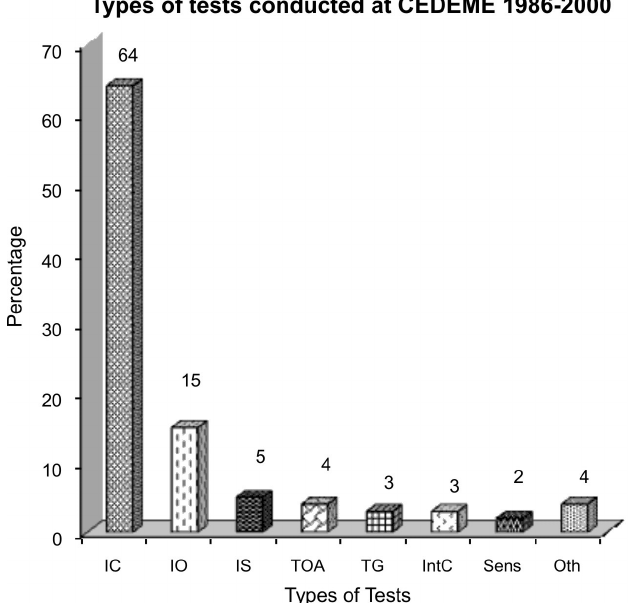
FIGURE 1 – Acute biological assays, considering percentages for 602 tests conducted at Cedeme/Unifesp between 1986 and 2000. The types of assay are indicated in abscissa: IC=cutaneous irritation; IO=eye irritation (not after 1995); IS= Systemic Injection; TOA= Oral acute toxicity; TG= General toxicity; IntC= Intracutaneous toxicity; Sens= Sensitization of skin; Oth=other (Implantation, Pyrogen, Acute dermal toxicity, and Mucosa Irritation).